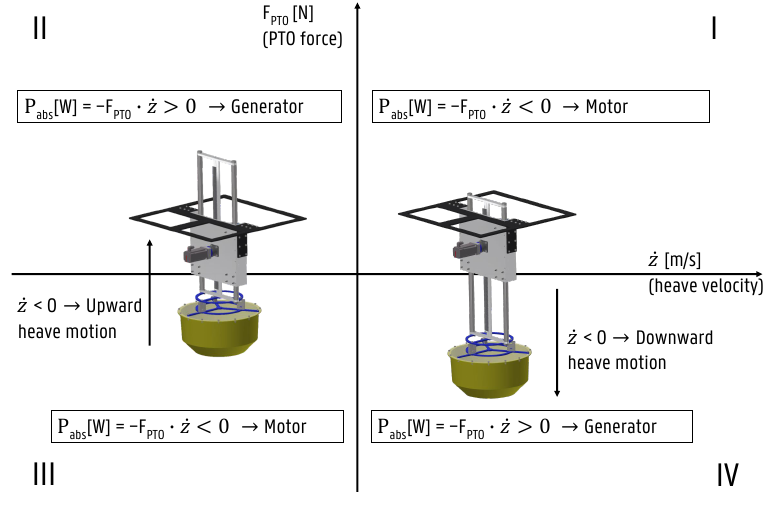
Figure 17. Power generation